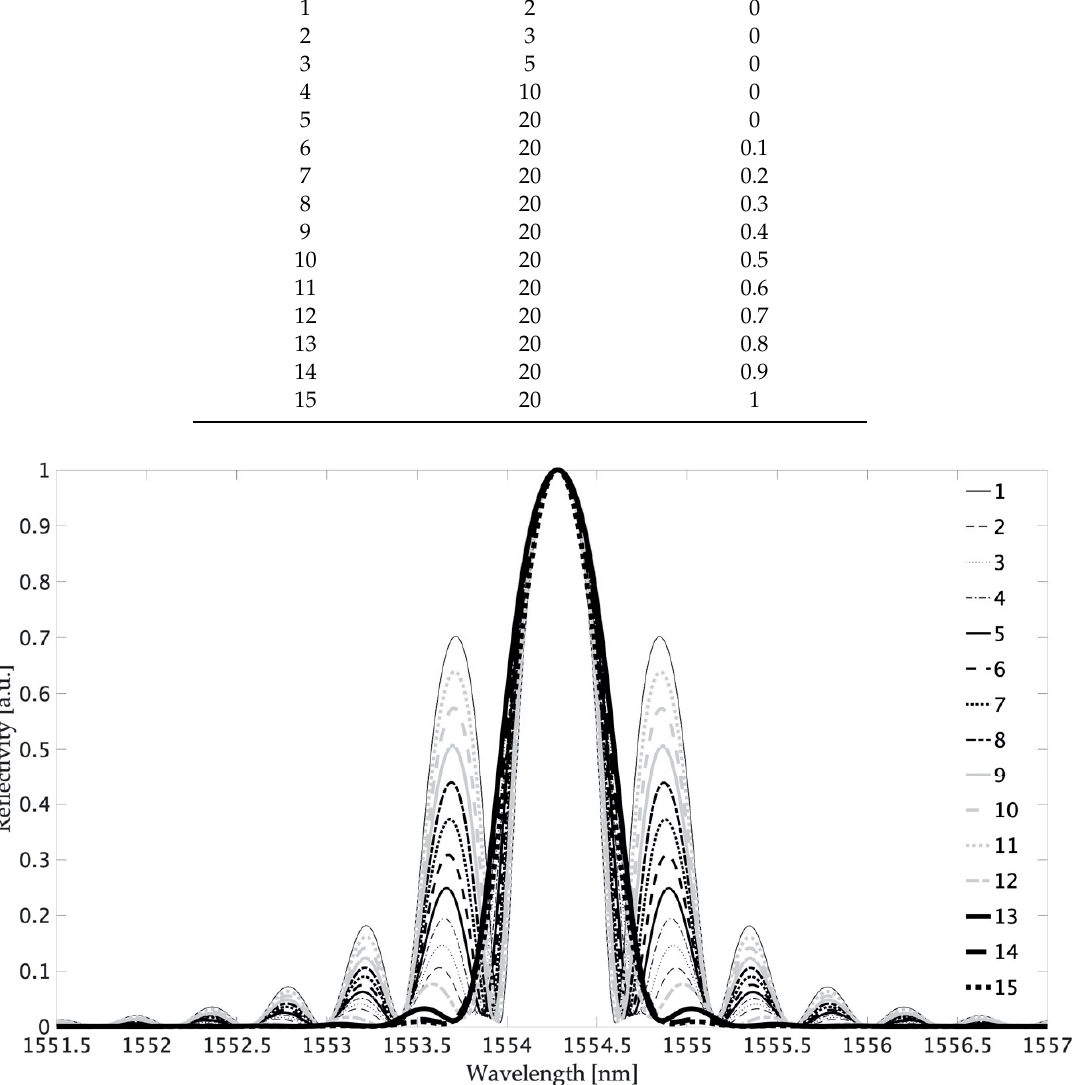
Figure 3. Spectra of the fiber Bragg gratings for apodization profiles from Figure 1.